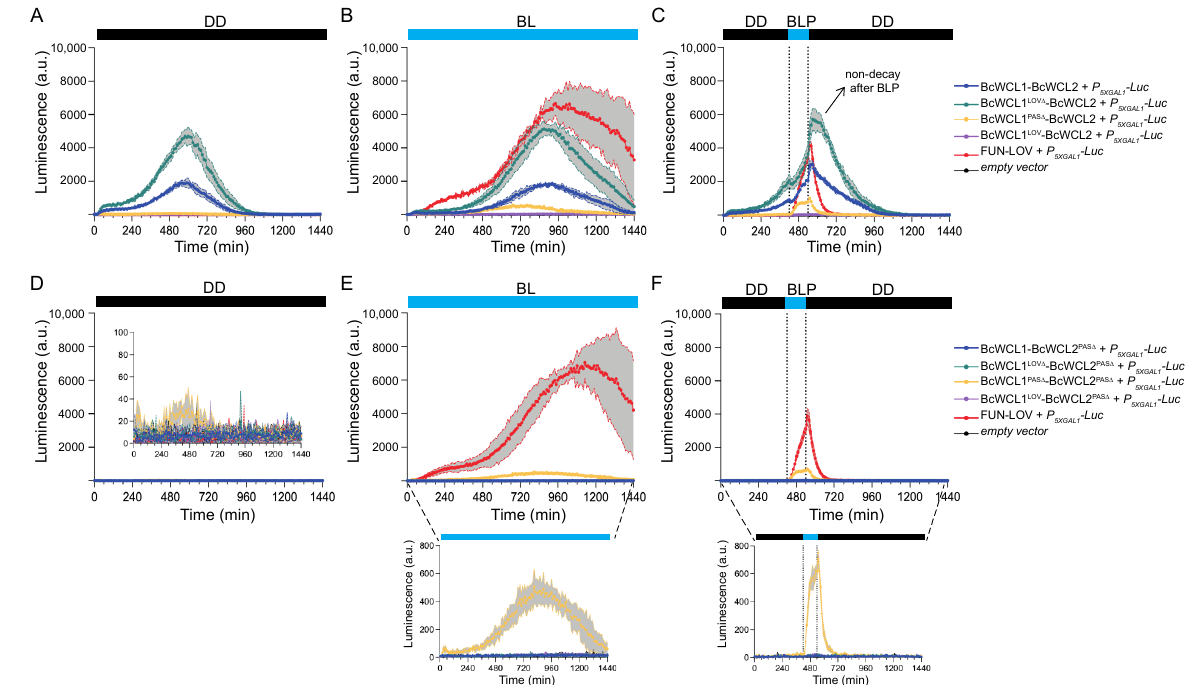
Figure 3. Protein–protein interaction between BcWCL1 and BcWCL2 is mediated mainly by PAS domains. Different variants of the BcWCL1 protein were assayed for protein–protein interaction with the full length BcWCL2 or BcWCL2 without the PAS domain. Luciferase expression was measured as luminescence in arbitrary units (a.u.) of the yeast cell cultures. The protein–protein interaction activates luciferase expression controlled by the 5XGAL1 synthetic promoter ( P 5XGAL1 ) under three different experimental conditions: ( A , D ) constant darkness (DD), ( B , E ) constant blue light (BL), and ( C , F ) a single blue-light pulse of 2 h duration (between dotted lines). The FUN-LOV optogenetic switch [32] was used as positive control of light-mediated protein–protein interaction that activates luciferase expression. In panels ( D – F ), the zoom shows the luciferase expression at lower scale. In all panels, the average of six biological replicates is shown, with standard deviation represented as shadowed grey regions.